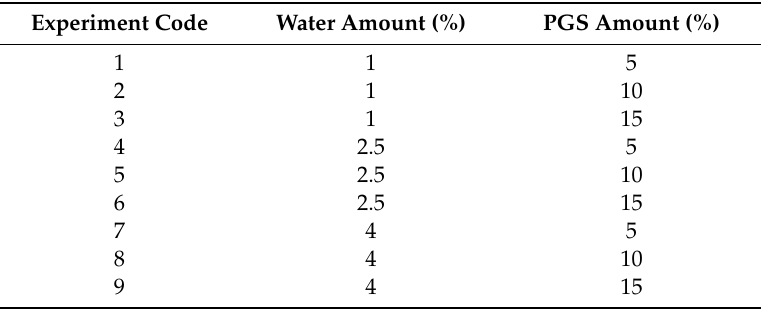
Table 3. A full matrix of (3 2 ) full factorial design for independent